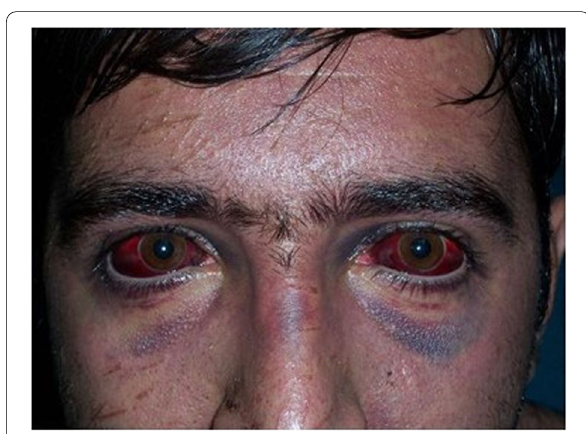
Fig. 5 Sub-conjunctival hemorrhage and facial blue discoloration starting to fade